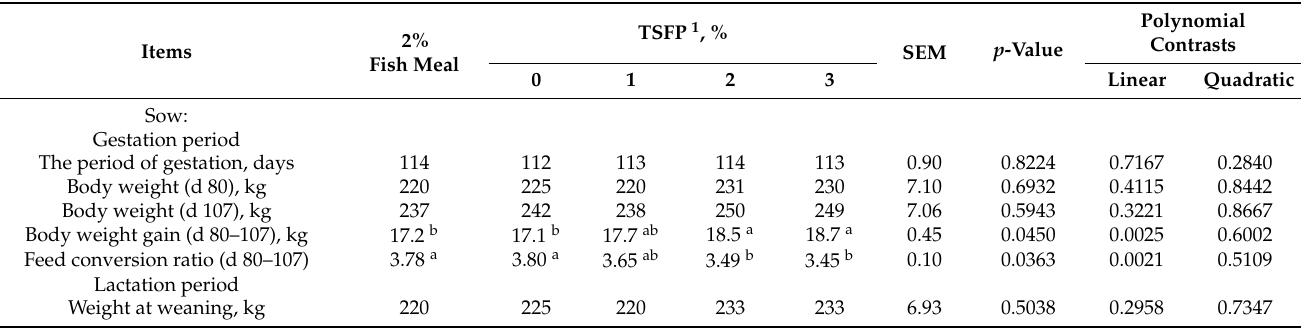
Table 3. The effects of two-stage fermented product on performance of sow and their piglets during lactation